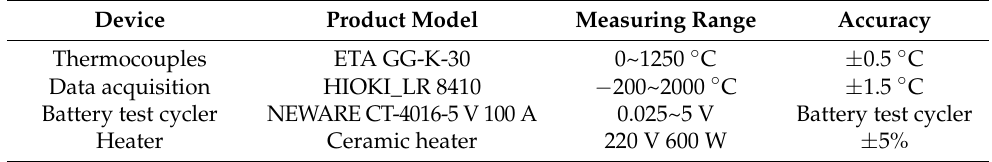
Table 4. Equipment models used in the experiment.